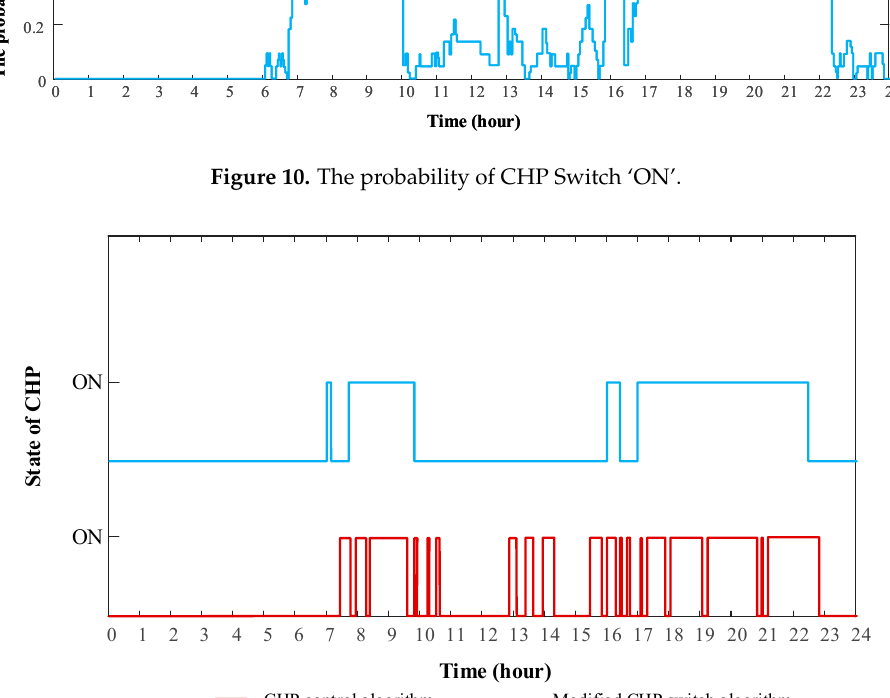
Figure 11. The states of CHP by applying CHP control algorithm and modified CHP control algorithm.